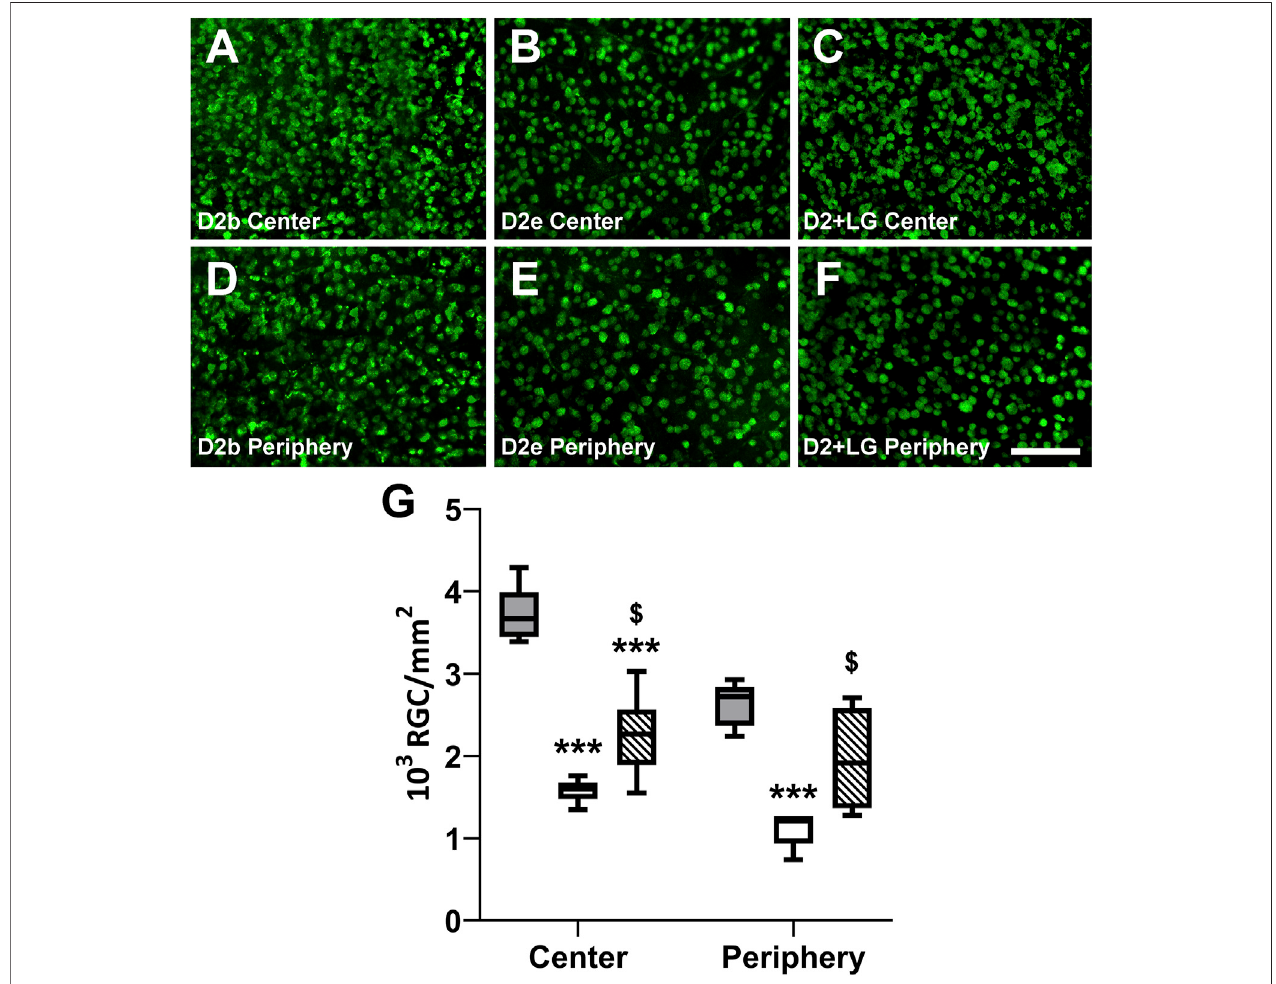
FIGURE4| BaselineandendpointdensitometricanalysisofRBPMS-immunostainedRGCsinwholemountretinas.Immuno fl uorescencephotomicrographsshow representative RBPMS immunostaining in central and peripheral areas of D2b, (A , D) , D2e (B , E) and D2+LG (C , F) retinas. Scale bar, 100 µm. (G) analysis of RBPMS positivecelldensityinD2b(grayboxes),D2e(whiteboxes),andD2+LG(dashedboxes)retinas.Boxplotsdescribethestatisticaldistributionof n (cid:1) 4independentretinas. Data were analyzed using two-way ANOVA with Bonferroni post-hoc test. * p < 0.05 vs D2.